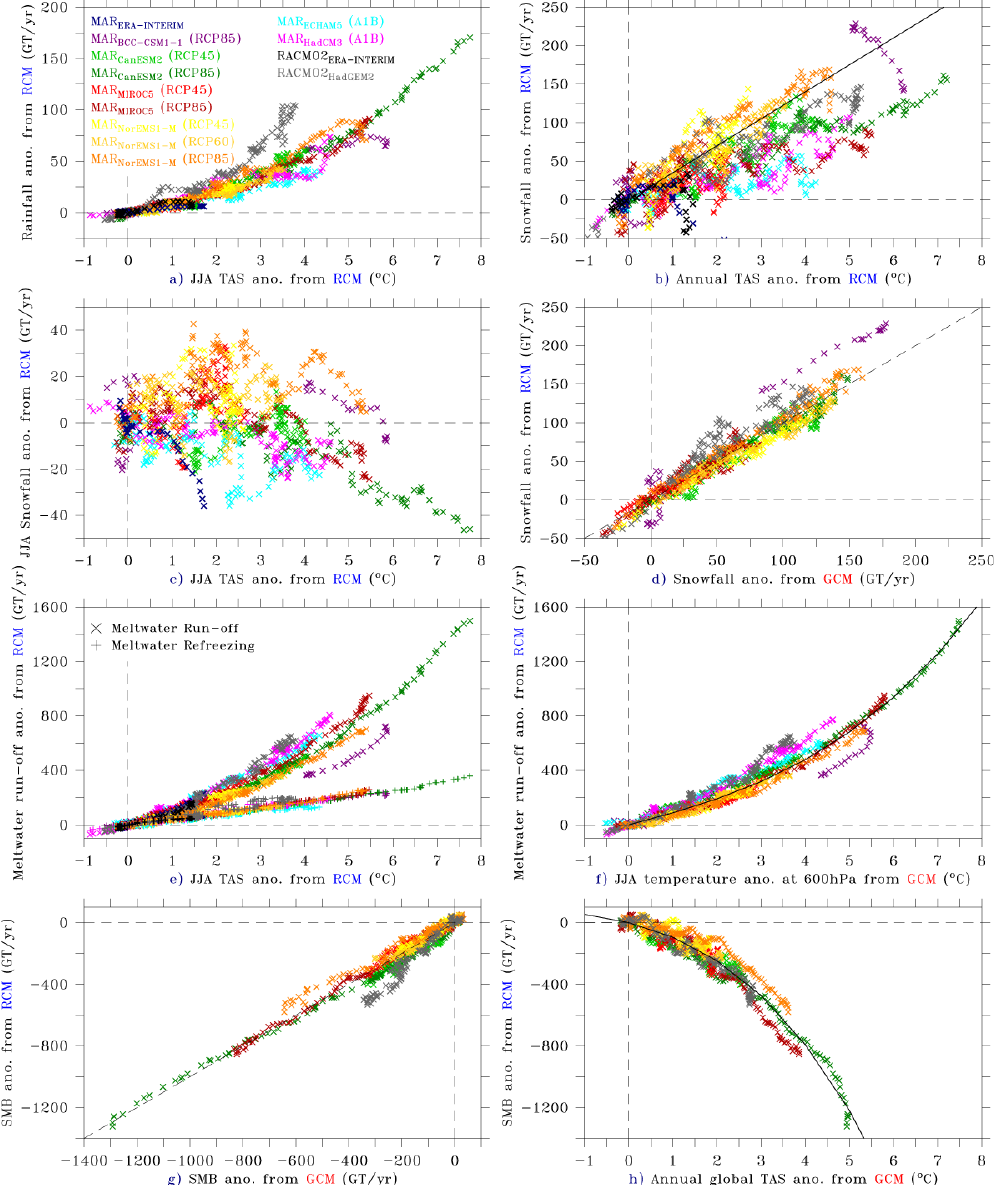
Fig. 6. (a) Anomalies of the annual total GrIS rainfall (in GTyr − 1 ) versus the JJA GrIS TAS anomaly (in ◦ C) simulated by the RCMs over 1980–2100. The anomalies are given with respect to 1980–1999 and a 10-yr running mean has been applied to the time series before making the scatter plot. (b) Same as (a) but for annual total snowfall vs annual GrIS TAS. (c) Same as (a) but for annual total meltwater run-off vs JJA GrIS TAS. (d) Same as (a) for annual total meltwater run-off vs the JJAS (from June to September) temperature anomaly from GCM taken at 600hPa over the area (20–70 ◦ W, 60–85 ◦ N). (e) Same as (a) but for the annual total SMB from RCMs vs the estimated one from GCMs using Eq. (1). (f) Same as (a) but for the annual total SMB from RCMs vs the annual global TAS from